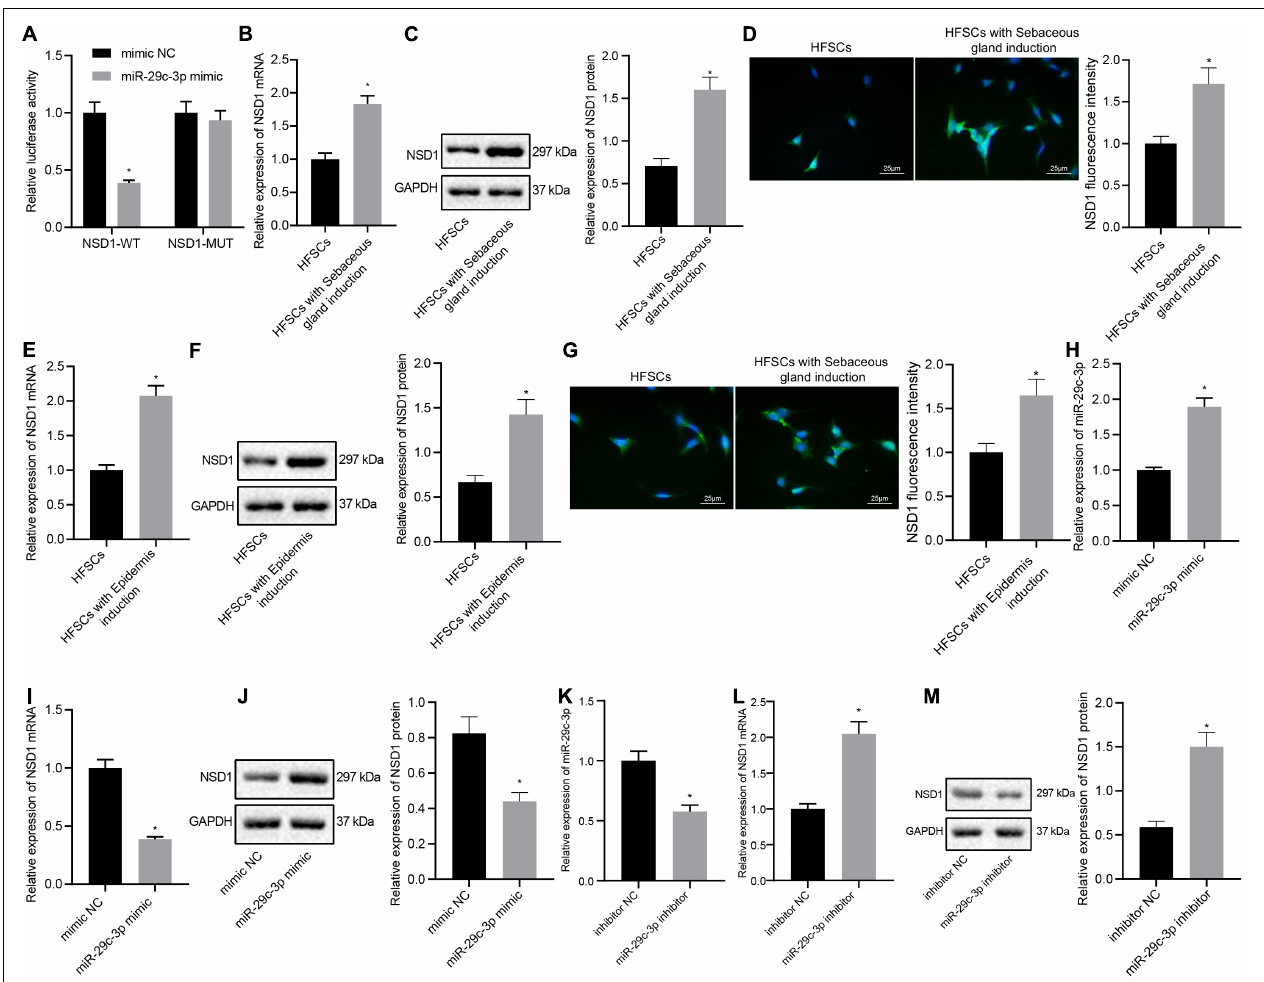
FIGURE 4 | miR-29c-3p targets NSD1 mRNA in differentiated HFSCs. (A) Detection of miR-29c-3p binding to NSD1 mRNA using the luciferase activity reporter assay. * p < 0.05 compared with treatment of mimic NC. (B) NSD1 mRNA expression after differentiation of HFSCs into sebaceous gland cells as determined by RT-qPCR. * p < 0.05 compared with HFSCs. (C) NSD1 protein level after differentiation of HFSCs into sebaceous gland cells as determined by Western blot analysis. * p < 0.05 compared with HFSCs. (D) NSD1 fluorescence intensity after differentiation of HFSCs into sebaceous gland cells as determined by immunofluorescence assay (scale bar = 25 µ m). * p < 0.05 compared with HFSCs. (E) NSD1 mRNA expression after differentiation of HFSCs into epidermal cells as determined by RT-qPCR. * p < 0.05 compared with HFSCs. (F) NSD1 protein level after differentiation of HFSCs into epidermal cells as determined by Western blot analysis. * p < 0.05 compared with HFSCs. (G) NSD1 fluorescence intensity after differentiation of HFSCs into epidermal cells as determined by immunofluorescence assay (scale bar = 25 µ m). * p < 0.05 compared with HFSCs. (H) miR-29c-3p expression levels in HFSCs treated with miR-29c-3p mimic as determined by RT-qPCR. (I) NSD1 mRNA expression in HFSCs treated with miR-29c-3p mimic as determined by RT-qPCR. * p < 0.05 compared with treatment of mimic NC. (J) NSD1 protein level in HFSCs treated with miR-29c-3p mimic as determined by Western blot analysis. * p < 0.05 compared with treatment of mimic NC. (K) miR-29c-3p expression levels in HFSCs treated with miR-29c-3p inhibitor (plasmid suppressing the expression of miR-29c-3p) as determined by RT-qPCR. (L) NSD1 mRNA protein expression in HFSCs treated with miR-29c-3p inhibitor as determined by RT-qPCR. * p < 0.05 compared with treatment of mimic NC. (M) NSD1 protein level in HFSCs treated with miR-29c-3p inhibitor as determined by Western blot analysis. * p < 0.05 compared with treatment of mimic NC. The data are expressed as mean ± standard deviation, and comparisons between two groups were analyzed by unpaired t test. The experiment was repeated three times.